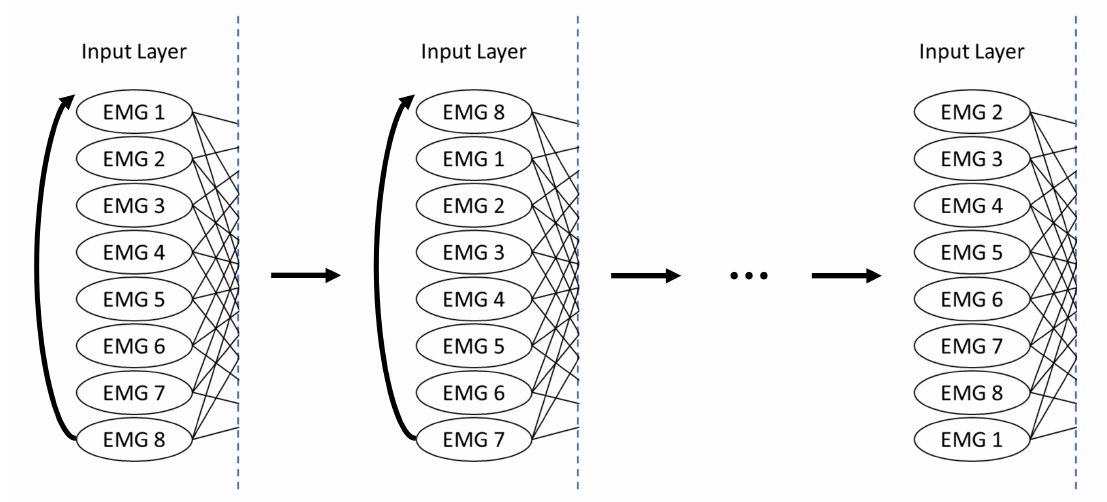
Figure 7. Virtual rotation of the 8 channels of electromyography (EMG) sensors in the neural